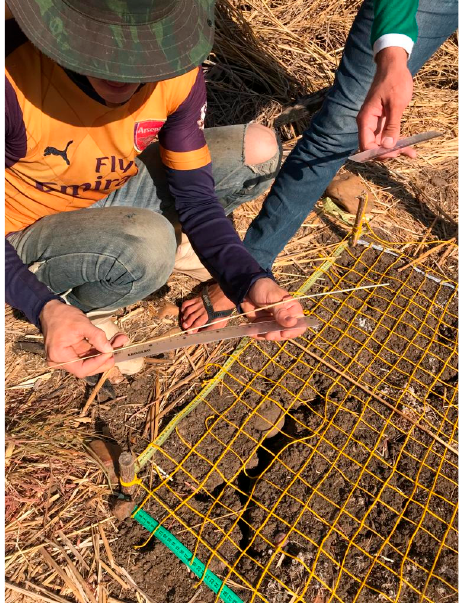
Figure 4. Crack monitoring in situ .